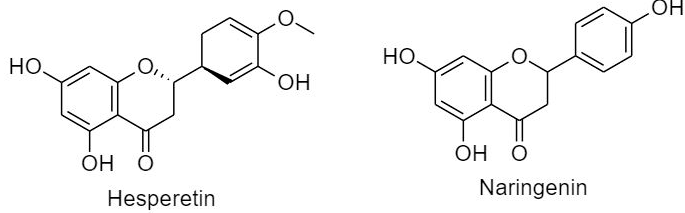
Figure 6. Flavanones. Hesperetin and naringenin.